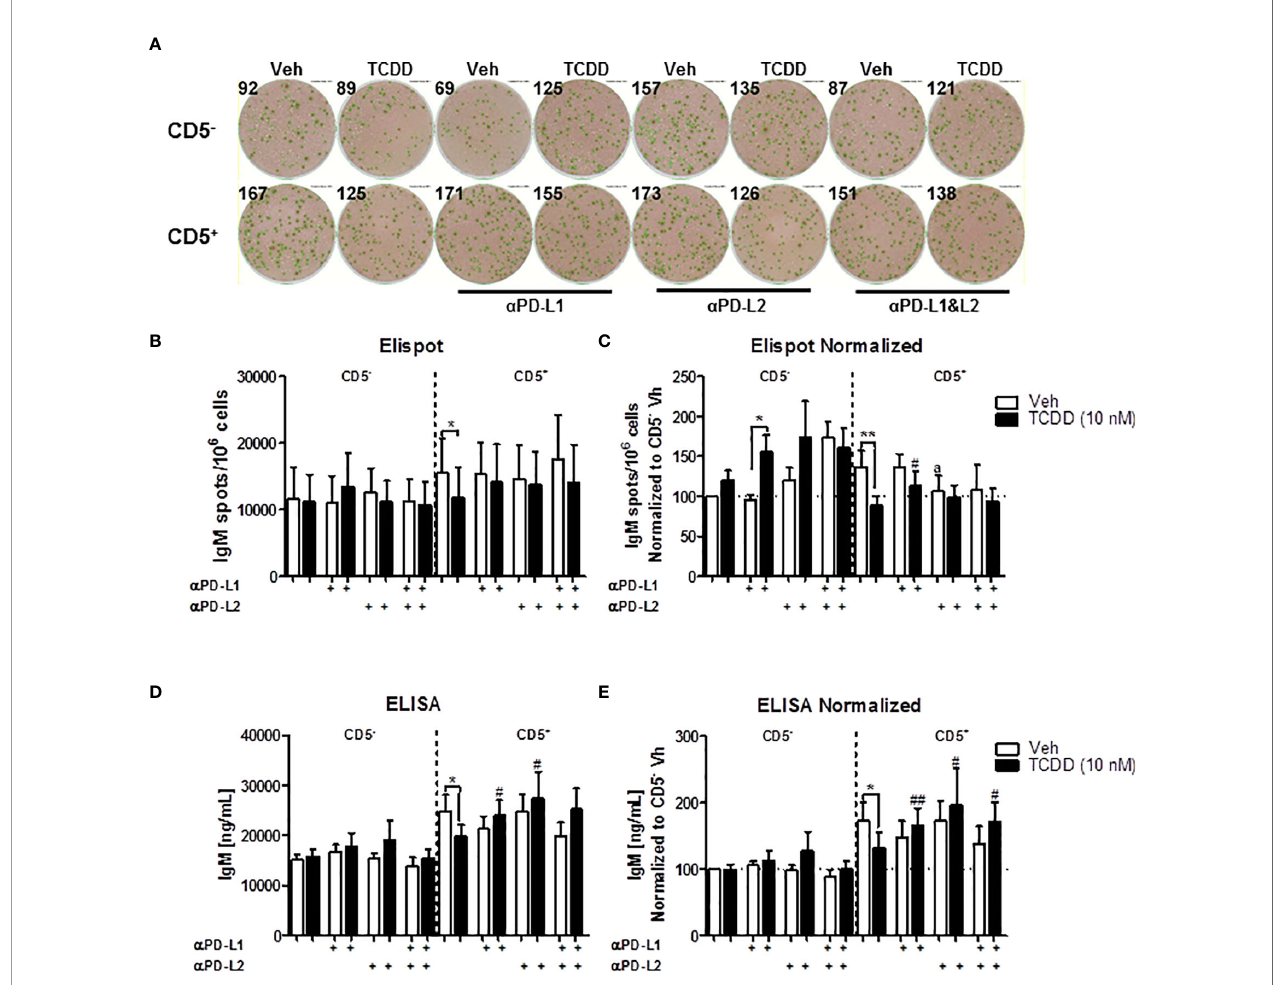
FIGURE 9 | Antibody blockade of PD-L1 or PD-L2 promotes IgM secretion by TCDD-treated CD5 + B cells. To determine the contribution of PD-1 ligands to the TCDD-mediated suppression of IgM secretion, we leveraged PD-1 ligand antibody blockade. Brie fl y, human CD5 +/- B cells were isolated, activated, and treated (Veh or TCDD) as described. At the initiation of culture, 1 m g/mL of either a PD-L1 or a PD-L2 was added and cells were cultured for 7 days. Following the culture period, cells and culture supernatants were collected for IgM enumeration. Representative ELIspot wells from a single donor are shown in (A) . Averaged raw numbers of IgM secreting cells are shown in (B) and normalized data in ( C) . Averaged IgM concentrations from culture supernatants are shown in (D) and normalized data are shown in ( E) . Determinations were made using B cells from 8 human donors (N = 8) across three independent experiments. Data presented in the fi gure were normalized to CD5 - Veh without anti-PD ligand treatments. Signi fi cant differences between Veh and TCDD are indicated by * p < 0.05 and ** p < 0.01. Signi fi cant differences between TCDD (no ligand blockade) and indicated TCDD-treated groups are indicated by # p < 0.05 and ## p < 0.01. Signi fi cance was determined using a two-way ANOVA followed with a Tukey ’ s posttest. Signi fi cant differences between Veh and Veh treated with PD ligand are indicated by 'a' p <